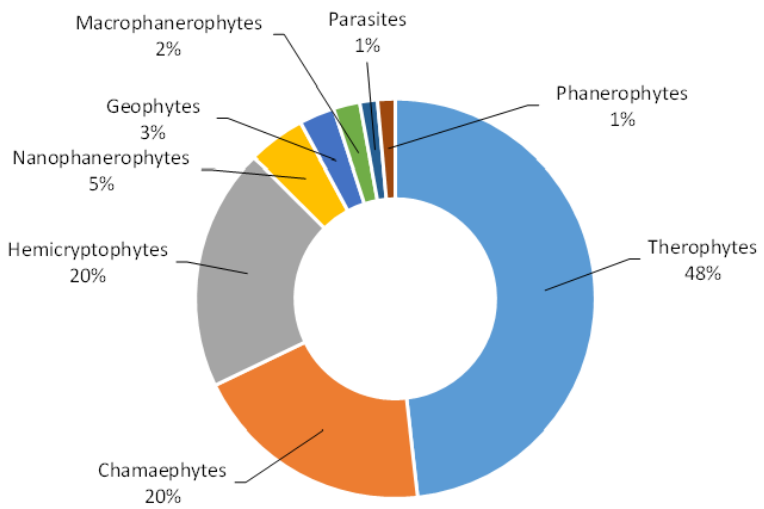
Figure 4. Life form distribution of plant species in the arid and desert rangelands of Tataouine, Tunisia (spring 2018).